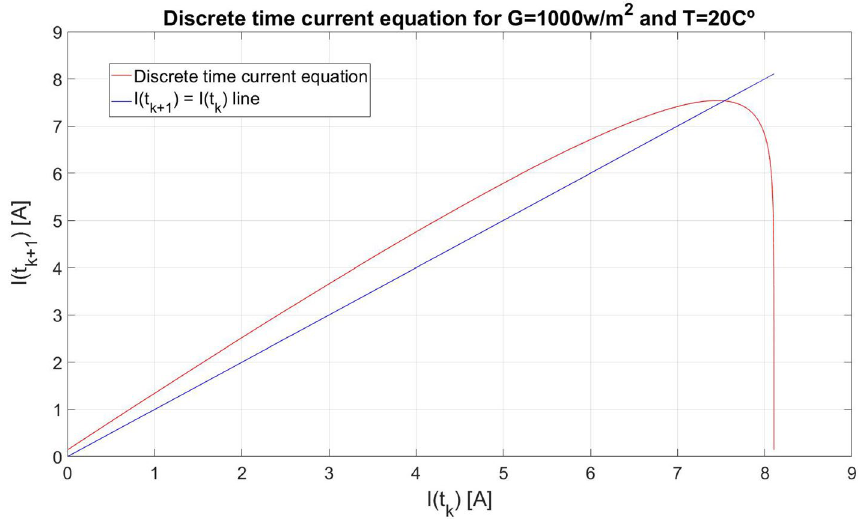
Figure 5. Discrete time current equation for 1000 W/m 2 irradiance and 20 °C